Question: Briefly state, in one sentence, what is plotted here.
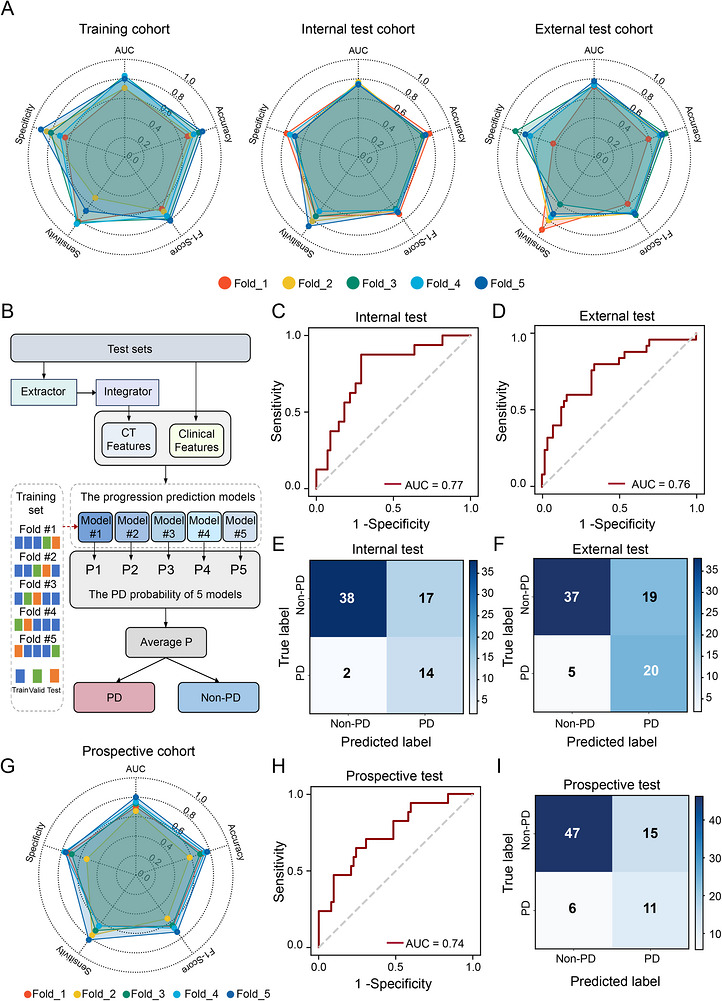
Answer: Performance of the tumor progression prediction model. (A) Performance of the fivefold cross‐validation models in the training, internal test, and external test cohorts. (B) Workflow for predicting progression in the internal and external test cohorts. Temporal multimodal features were input into five distinct models. Each output a predicted probability. The average predicted probability was used to determine the classification as PD or non‐PD. (C and D) ROC curves of the prediction model in the internal and external test cohorts. (E and F) Confusion matrices of model predictions for the internal and external test cohorts. (G–I) Performance of the fivefold models, ROC curve of the ensemble model, and confusion matrix of the ensemble model in a prospective cohort.